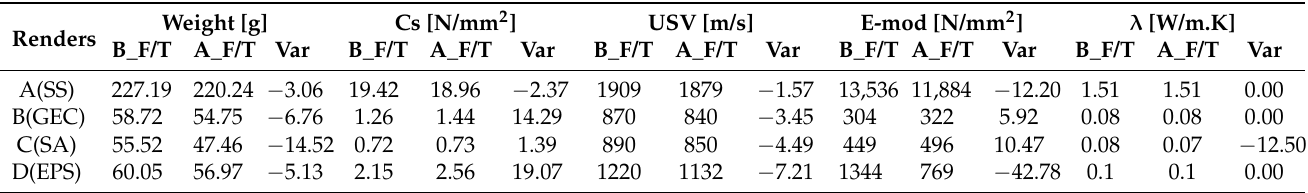
Table 3. Results from freeze/thaw cycles.